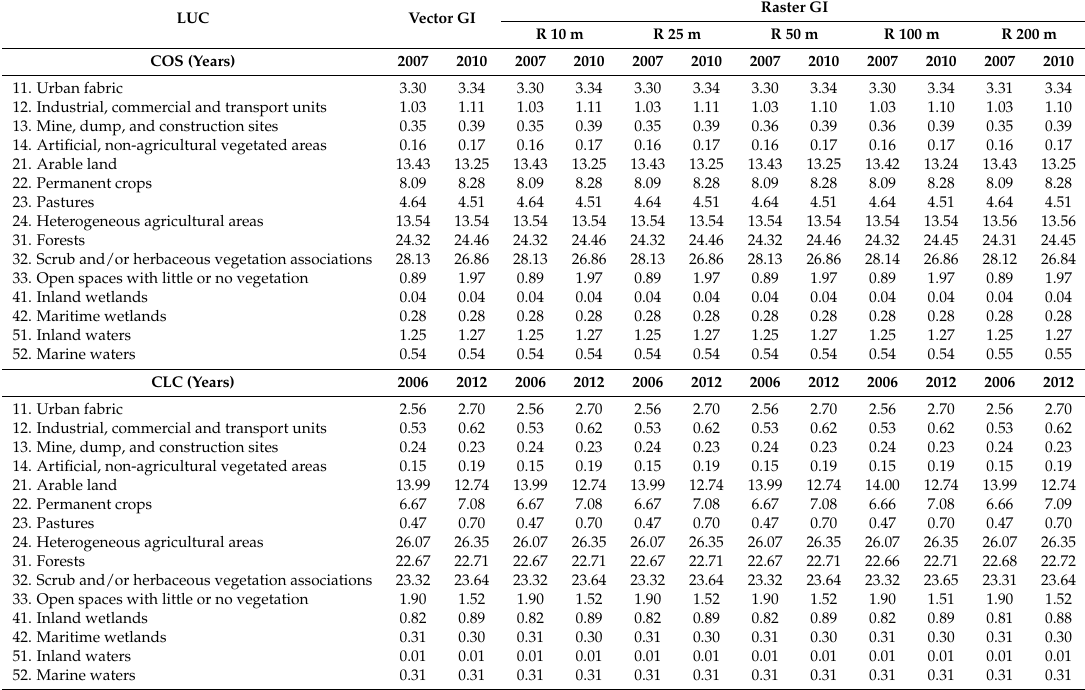
Table 4. Area of LUC classes (% of mainland Portugal, 88,962.5 km 2 ) obtained by vector GI and raster outputs with different resolutions for the different years, by each LUC dataset (COS and